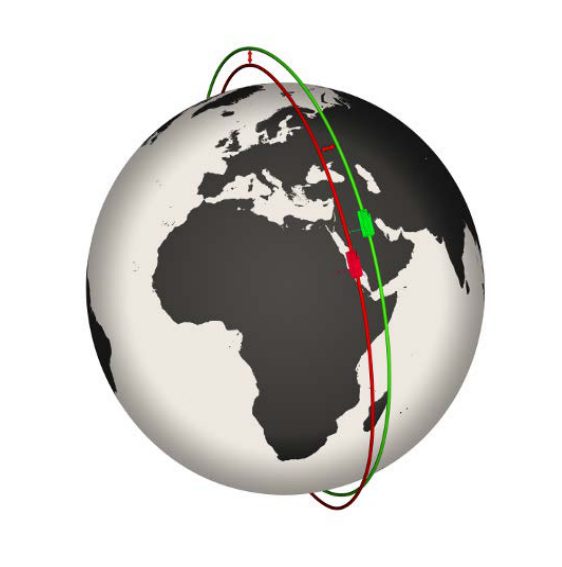
Figure 2. Orbit illustration of Helix formation. Red: TSX, Green: TDX; typical baseline values vary from 120 to 500